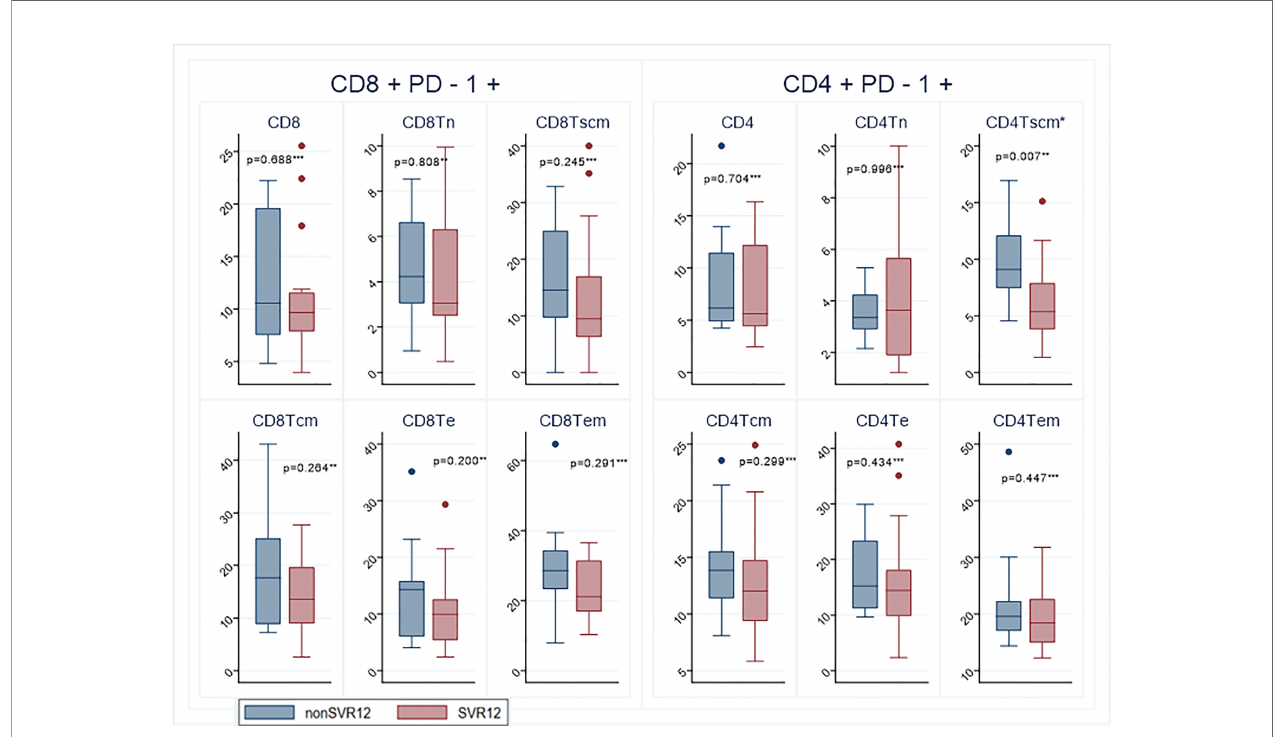
FIGURE 1 | Expression of the inhibitory receptors PD1 on CD4+ and CD8+ lymphocytes at baseline from patients with virological relapse (non SVR) and patients who achieved cure (SVR). The colored dots represent measurements outside the IQR range. Sustained virological response (SVR); naïve T cells (Tn); T stem cells memory T-cells (Tscm); central memory T cells (Tcm); terminal effector T-cells (Te); effector memory T cells (Tem). Signi fi cant values marked with *. Statistical analyzes according to test for signi fi cance ** t test *** Wilcoxon Mann-Whitney